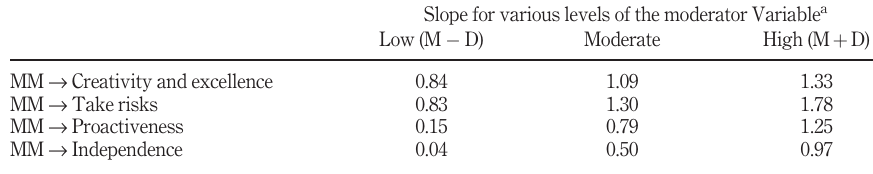
Table 5. Results of simple slope analysis (unstandardized